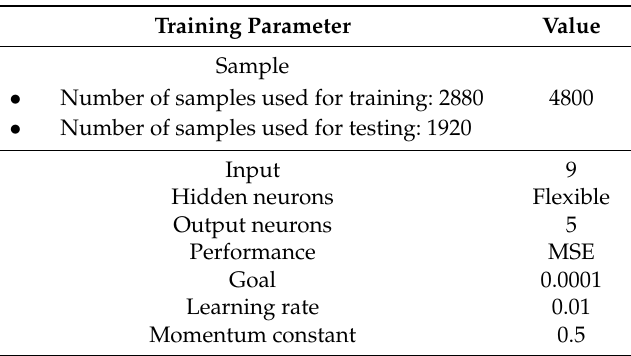
Table 9. Parameters for multilayer perceptron (MLP) training.